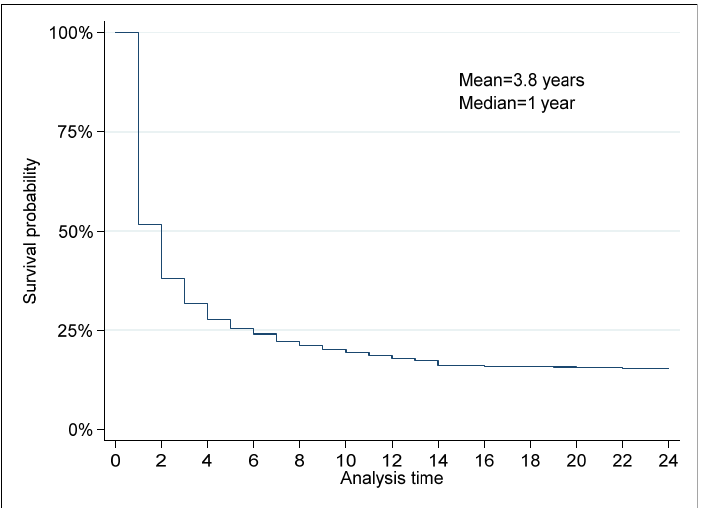
Figure 6. Kaplan–Meier survival estimate for Russian non-renewable energy exports. Source: Au- thors’ elaboration based on data retrieved from CEPII database.